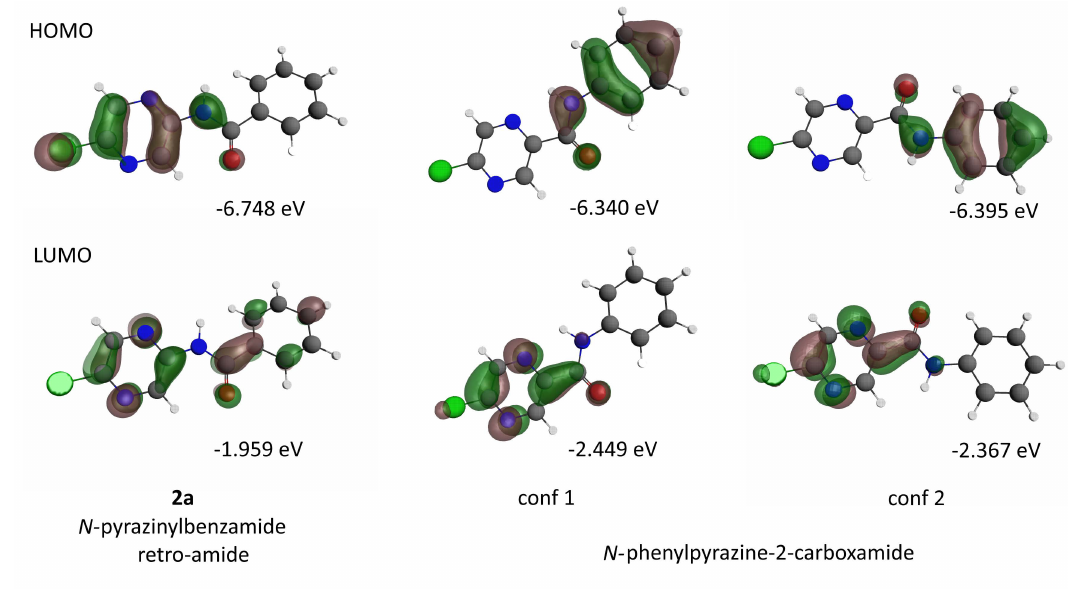
Figure 5. Predicted HOMO and